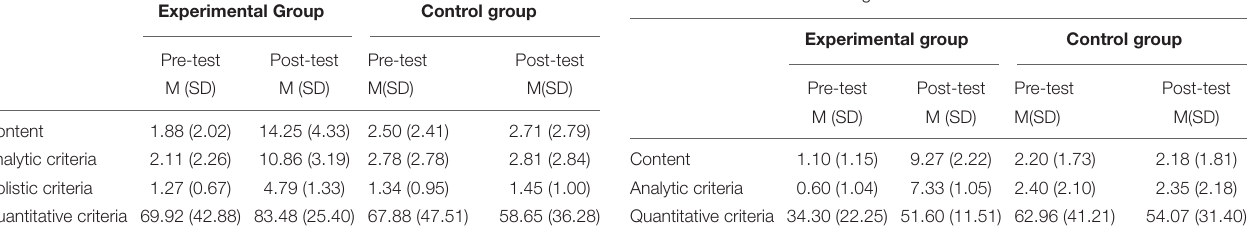
TABLE 2 | Means (M), Standard Deviations (SD) of the story writing of the english text criteria for the below average